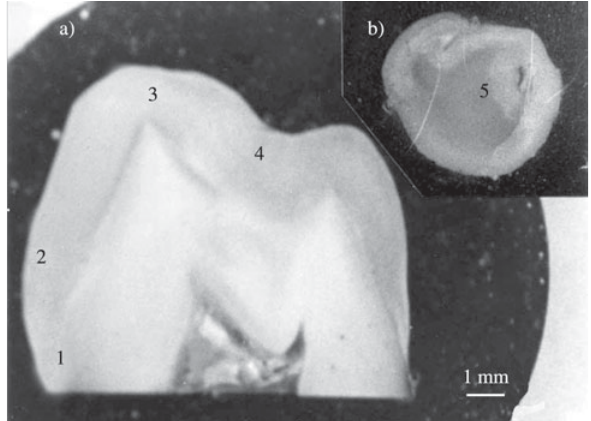
) transverse sample 2